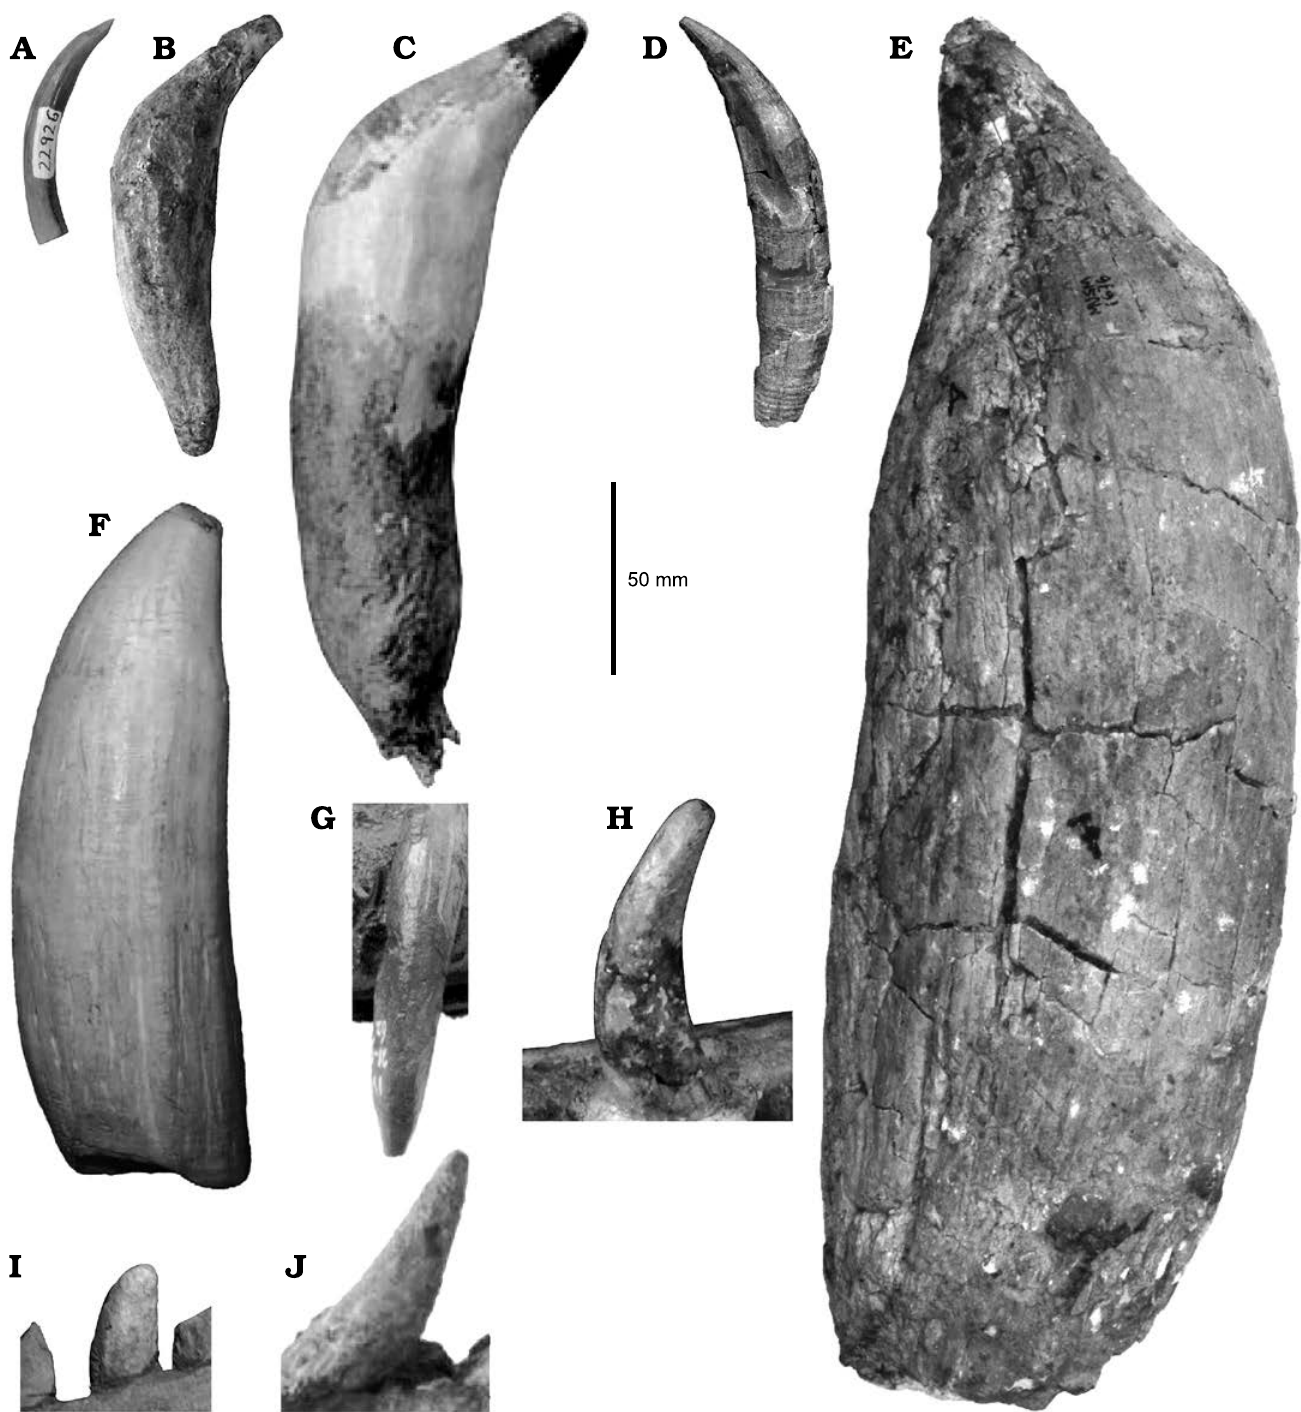
Fig. 6. Comparisons of non-kogiid physeteroid teeth from the Miocene. A – F . Isolated teeth of: Orycterocetus crocodilinus (Cope, 1867), Calvert Formation, between Maryland and Virginia, USA ( A , USNM 22926), Acrophyseter sp., Pisco Formation, Cerro los Quesos, Peru ( B , MUSM 2182; modified from Lambert et al. 2016), Zygophyseter varolai (Bianucci and Landini, 2006), Pietra Leccese Formation, Cisterna Quarry, Italy ( C , MAUL 229/1; modified from Bianucci and Landini 2006), Physeteroidea indet., Gran Bajo del Gualicho Formation, Rio Negro, Argentina ( D , MLP 76-IX-5-1, “ Preaulophyseter ” sensu Caviglia and Jorge 1980), Livyatan melvillei (Lambert, Bianucci, Post, de Muizon, Salas-Gismondi, Urbina, and Reumer, 2010), Pisco Formation, Cerro Colorado, Peru ( E , MUSM 1676; modified from Lambert et al. 2016), the extant Physeter macrocephalus (Linnaeus, 1758) ( F , MACN 29.768; modified from Perez et al. 2011). G . Maxillary tooth of Eudelphis mortezelensis (Du Bus, 1872), Berchem Formation, Antwerp, Belgium (IRSNB M.523; modified from Lambert 2008). H – J . Mandibular tooth of: Idiorophus patagonicus (Lydekker, 1893), Gaiman Formation, Chubut, Argentina ( H , MLP 5-2), “ Aulophyseter ” rionegrensis (Gondar, 1975), Gran Bajo del Gualicho Formation, Rio Negro, Argentina ( I , MLP 62-XII-19-1), and Physeterula dubusi (Van Beneden, 1877), Antwerp, Belgium ( J , IRSNB M.527; modified from Lambert